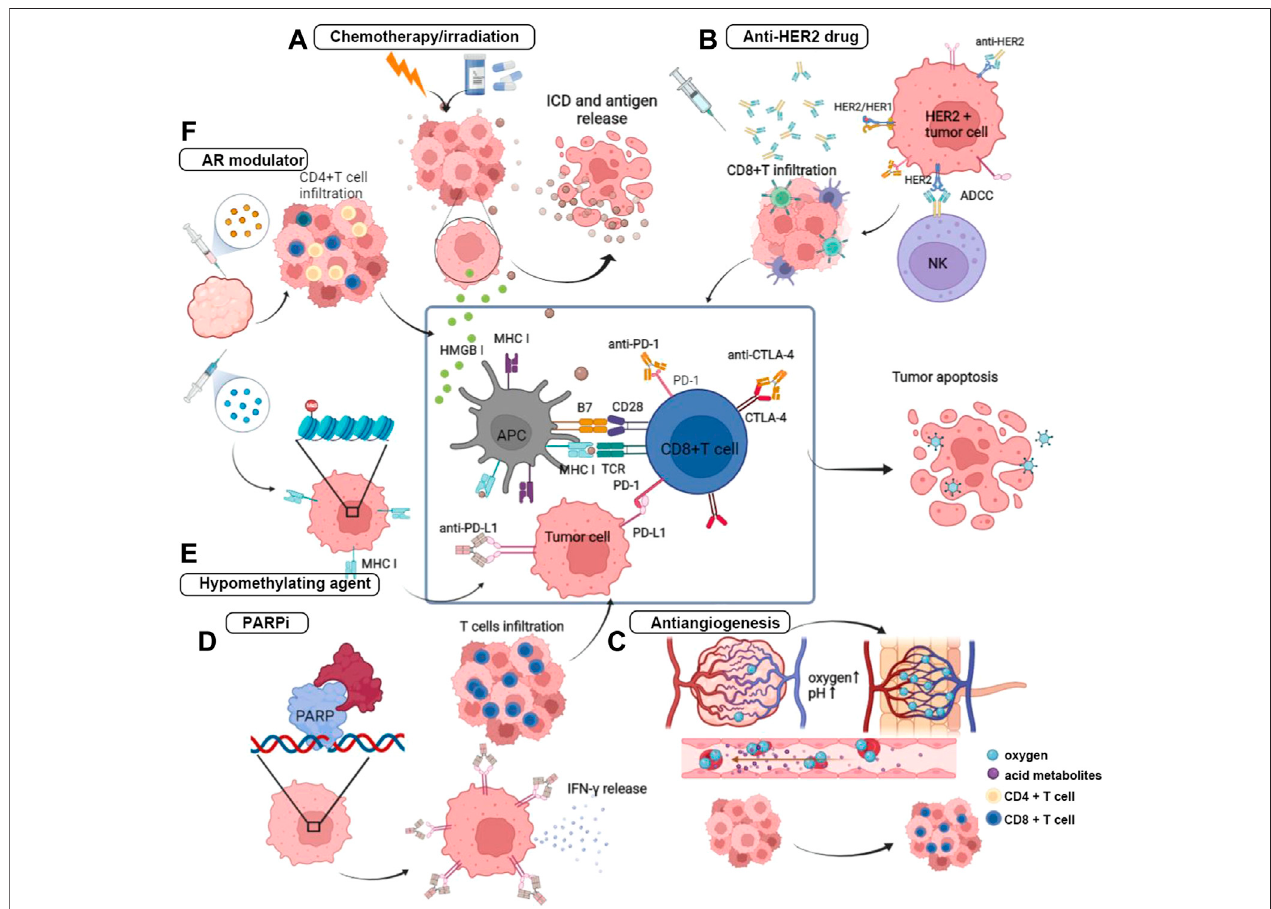
FIGURE 2 | Anti-tumor mechanisms of PD-1/PD-L1 blockade combining with other treatment regimens. (A) The primary mechanism of chemotherapy and irradiationincombinationwithICB istoinducedICD,and therebytopromotetherelease oftumor antigen.Underthepromotion ofICD, HMGBItranslocated toimprove antigen presentation and the following process of T cell activation. (B) The Fc structure of the monoclonal antibody of HER2 mediates the ADCC by binding with Fc receptor on the NK cells and promote the CD8-positive T cells in fi ltration. (C) Anti-angiogenic therapy acts on reshaping the disorder blood vessel and attenuating the hypoxic and acid TME. (D) PARPi inhibits the DNA damage repair by impeding the binding of PAPR on the broken DNA, and then induces the activation of IFN pathway and effector cells in fi ltration. (E) Hypomethylating agent prompts antigen presentation by upregulating the expression of MHC class I. (F) Androgen receptor antagonist inhibits the IL-10 release and T reg in fi ltrartion, and attracts effector T cells further.